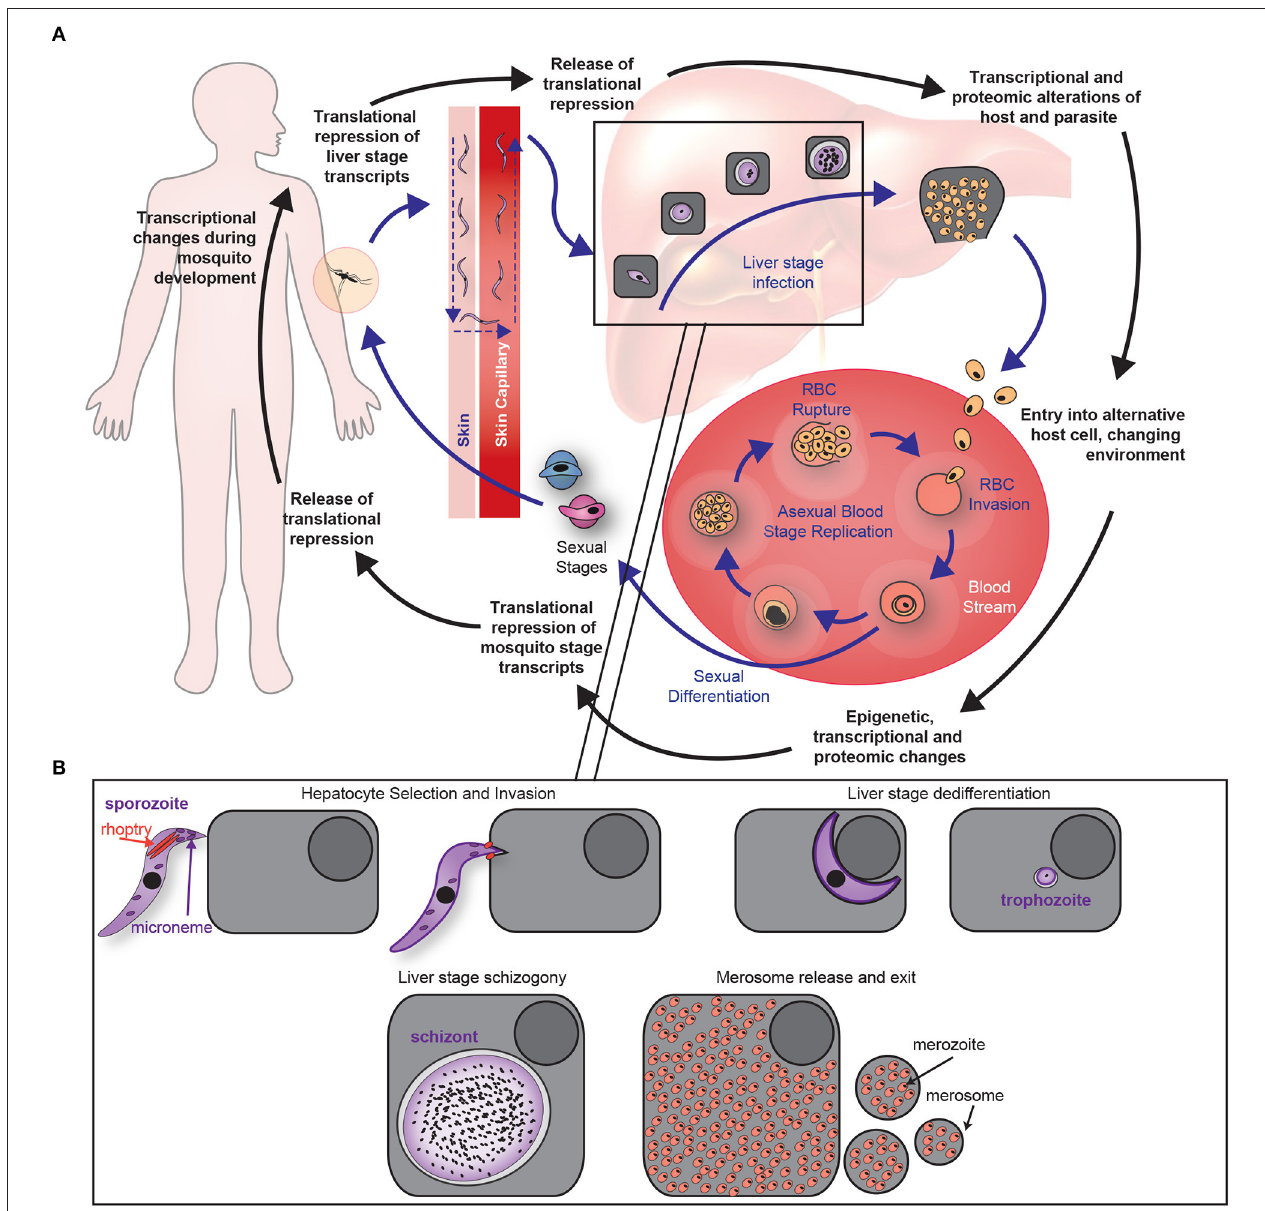
FIGURE 1 | Plasmodium life cycle. (A) Each stage of the malaria life cycle is accompanied by unique transcriptional or translational changes, which ultimately allow for successful transition to each stage of the life cycle. Red Blood Cell is abbreviated “RBC.” (B) Liver stage infection of a hepatocyte is a unique microenvironment that allows the parasite to invad and differentiate into several forms to ensure growth, replication, and eventual egress from the hepatocyte. These key transitions occur in specific subcellular locations during liver stage